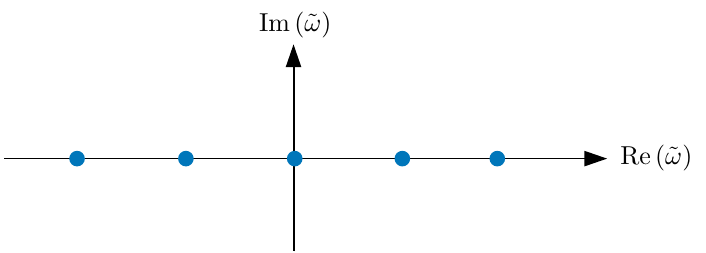
Figure 3 . The integrand in eq. (3.6) features an in(cid:12)nite number of saddle points, one for each vorticity (blue dots). All the saddle points lie in the real line, and are given by ~ ! k = 2 (cid:25)k= ( gp ). Notice the di(cid:11)erence with respect to the result for unscreened electric charge, where the only saddle point lies on the imaginary axis (see (cid:12)gure